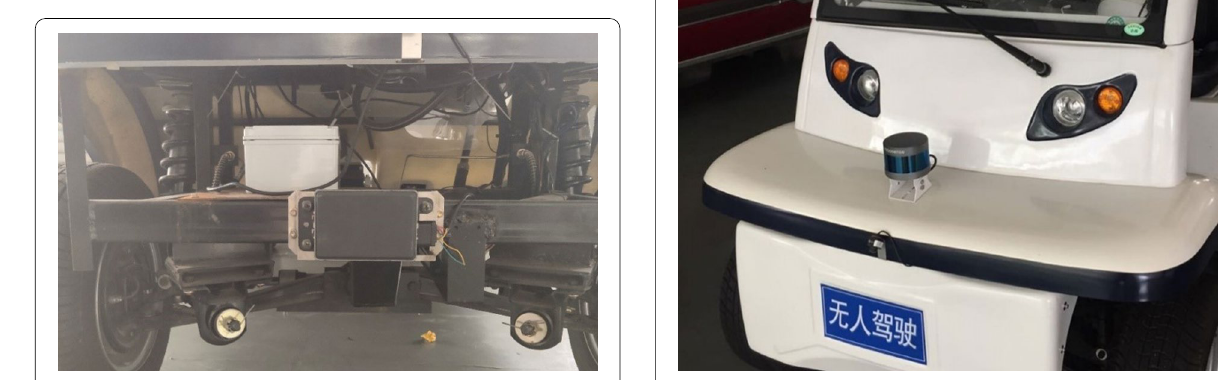
Figure 2 RS-LiDAR-16 installed on our autonomous